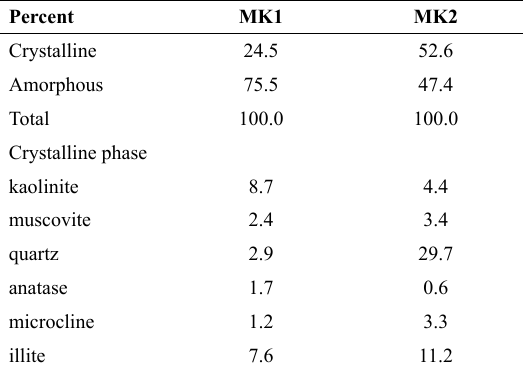
Table 3. Crystalline-amorphous quantification of MK1 and MK2 (T%).